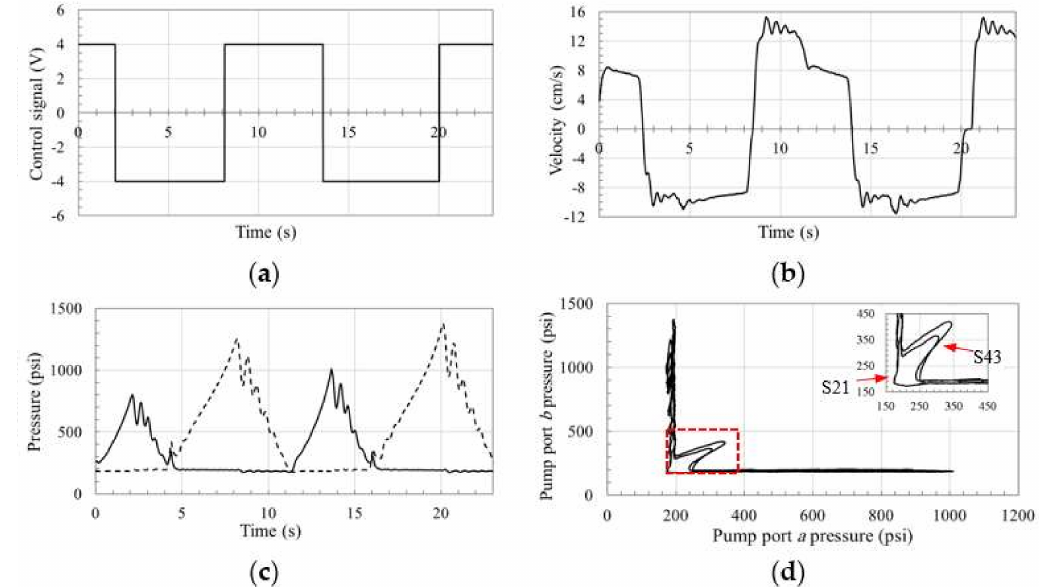
Figure 17. Performance of circuit using CC-SHV for a 368 kg attached mass: ( a ) input control signal; ( b ) actuator velocity; ( c ) pressures at the pump ports a (solid line) and b (dotted line); ( d ) pump pressure plane.